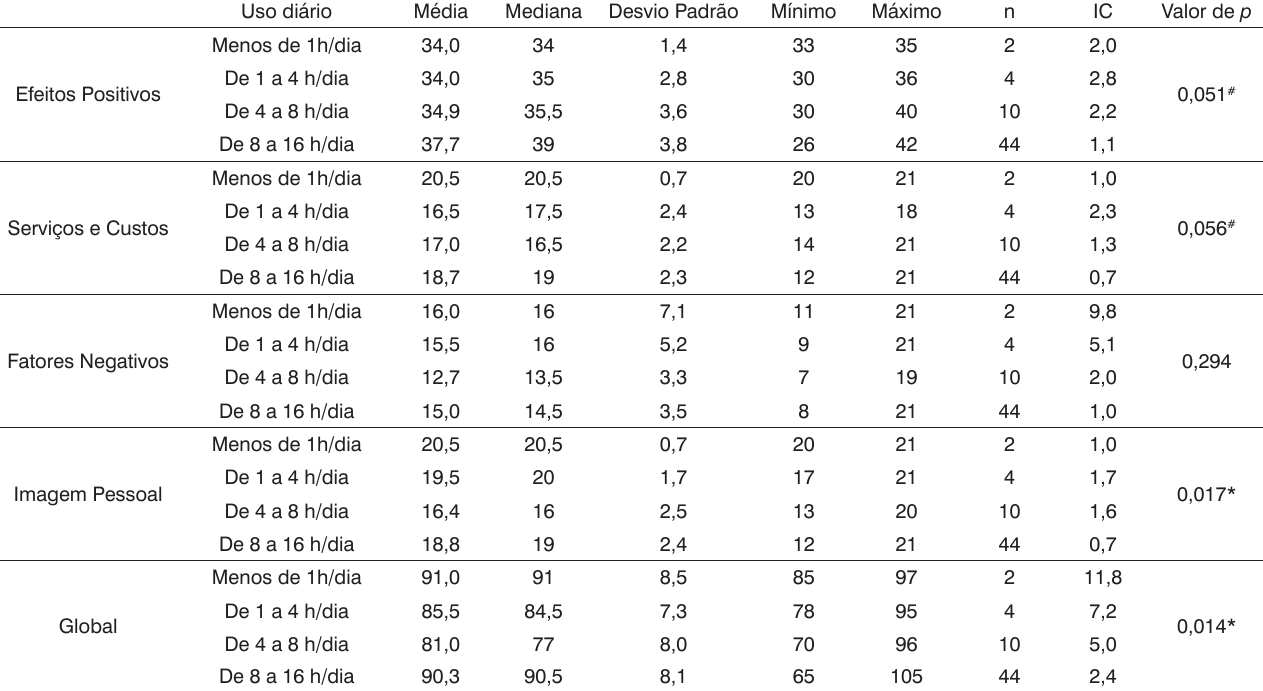
Tabela 3. Relação entre o uso diário de AASI e satisfação global e por subescala de pacientes protetizados na Clínica Lumiar avaliados entre setembro e outubro de